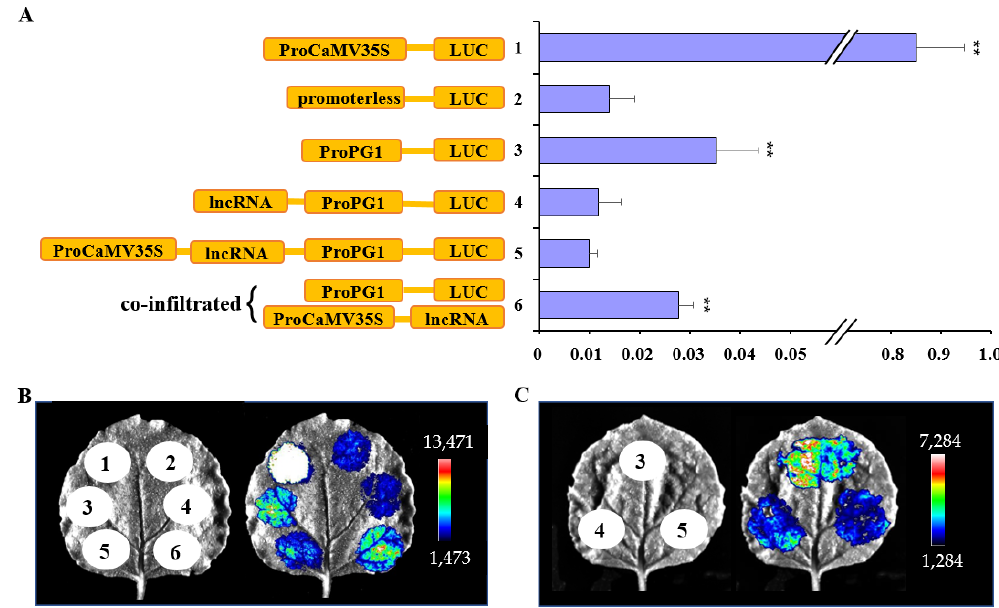
Figure 4. Luciferase activity assay of MdPG1 promoter. ( A ) The program shows Luc/Ren ratios in N. benthamiana leaves that were transiently transformed by infiltration of Agrobacterium containing five different constructs (1–5) or a combination of two constructs (6). Error bars represent standard deviation of three biological replicates. Asterisks indicate significant differences to promoterless-LUC control (2) by t -test: ** p < 0.01. ( B , C ) Luciferase imaging assays show the luminescence signals in the benthamiana leaves transformed with the same constructs as described in ( A ). The different colors indicate the luminescence intensity.